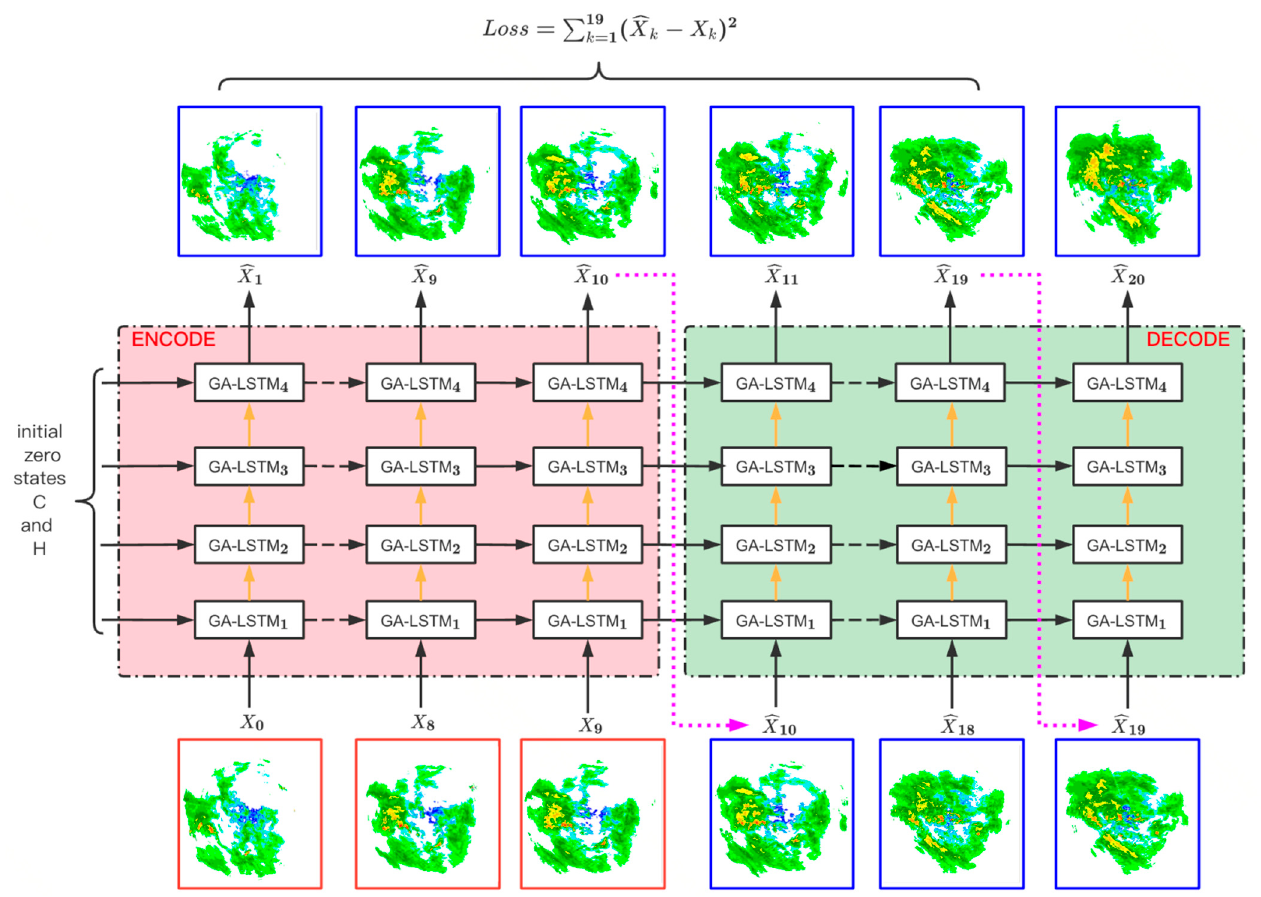
Figure 8. The flowchart of GARNN.